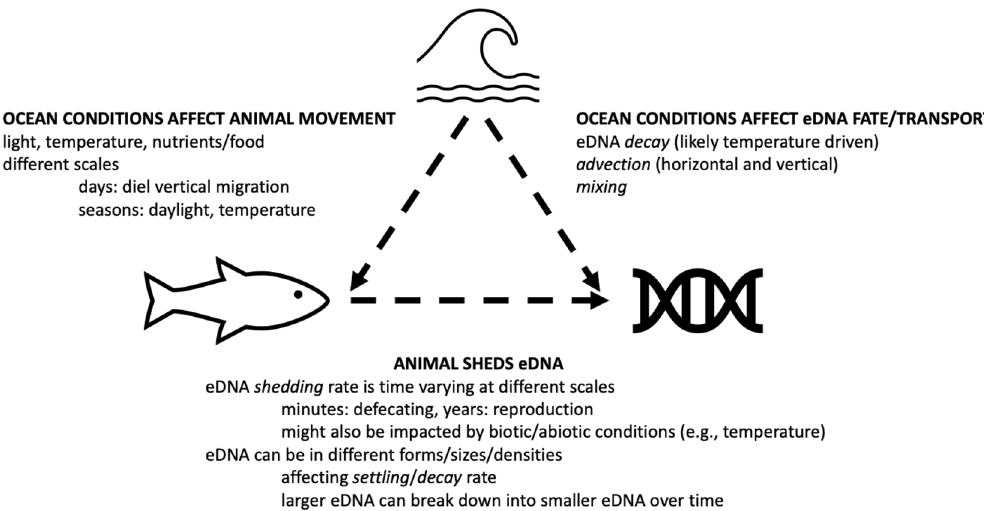
Figure 1. Conceptual model of the contributions of various factors to the eDNA vertical profiles. Organisms move in space and time while continuously shedding eDNA into the water column. After eDNA is shed from the organisms, it is subject to the influence of various transport, mixing and decaying processes, which also impact the vertical distribution of eDNA in the water column.